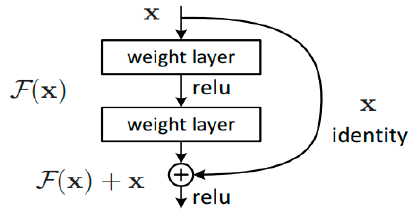
Figure 9. ReLu-convolution series.